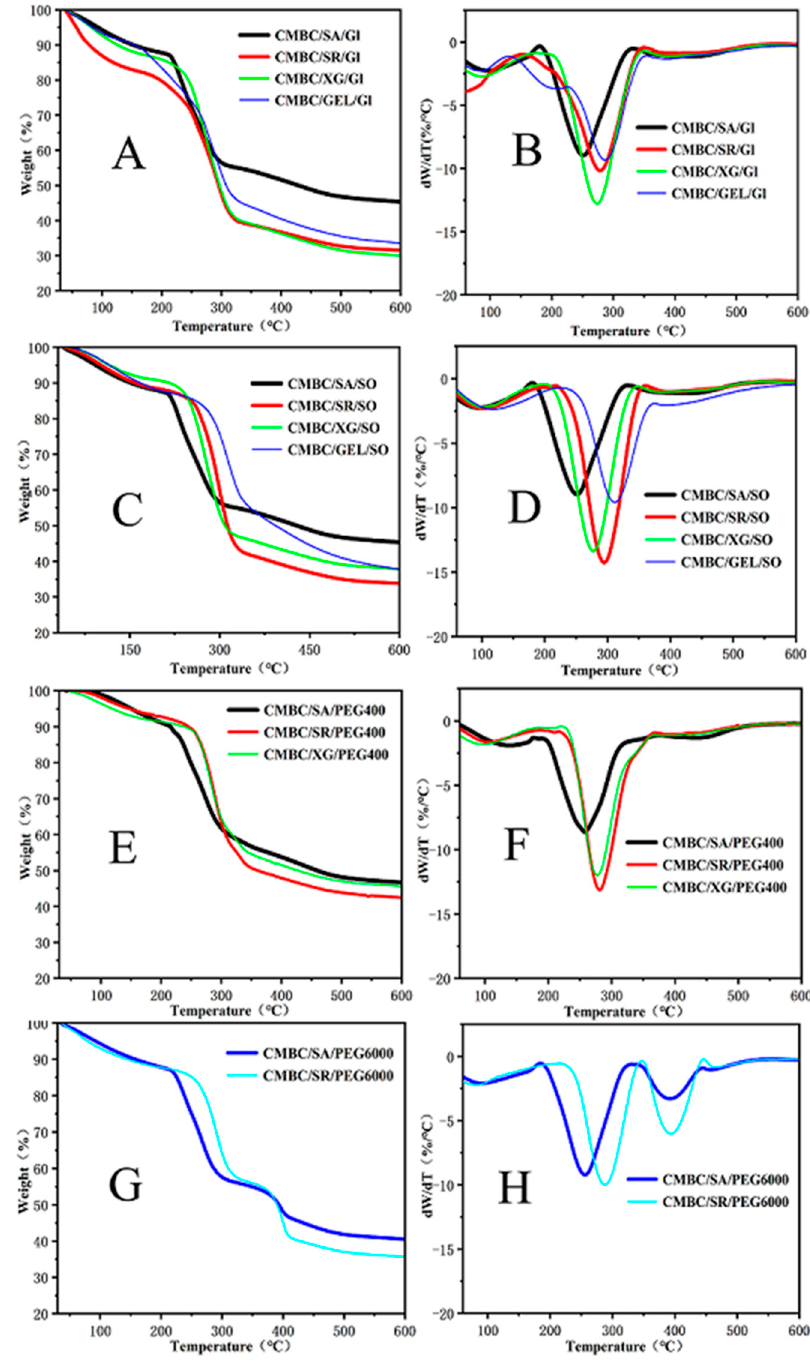
Figure 5. Pyrolysis curves of the composite films (( A , C , E , G ) for TG; ( B , D , F , H ) for DTG). (cid:4666)d (cid:2933) /d (cid:2930) (cid:4667) (cid:2923)(cid:2911)× (cid:4666)d (cid:2933) /d (cid:2930) (cid:4667) (cid:2923)(cid:2915)(cid:2911)(cid:2924) V (cid:2998) D =